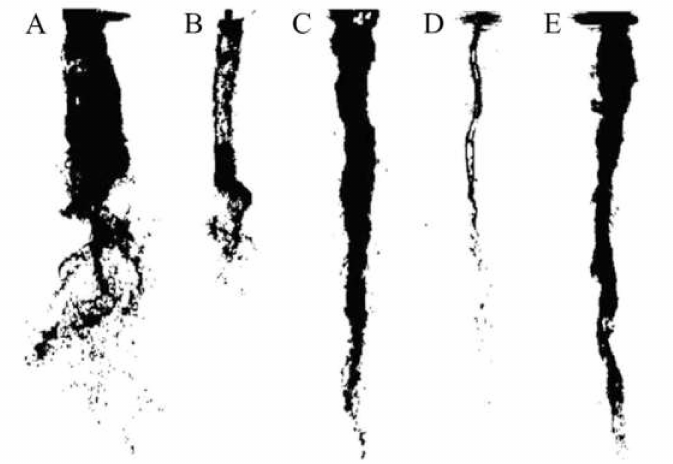
Figure 4. Cavitation vortex patterns at studied pump–turbine operation conditions according Table 3. ( A – E ) indicate different vortex patterns at different conditions according Table 3.